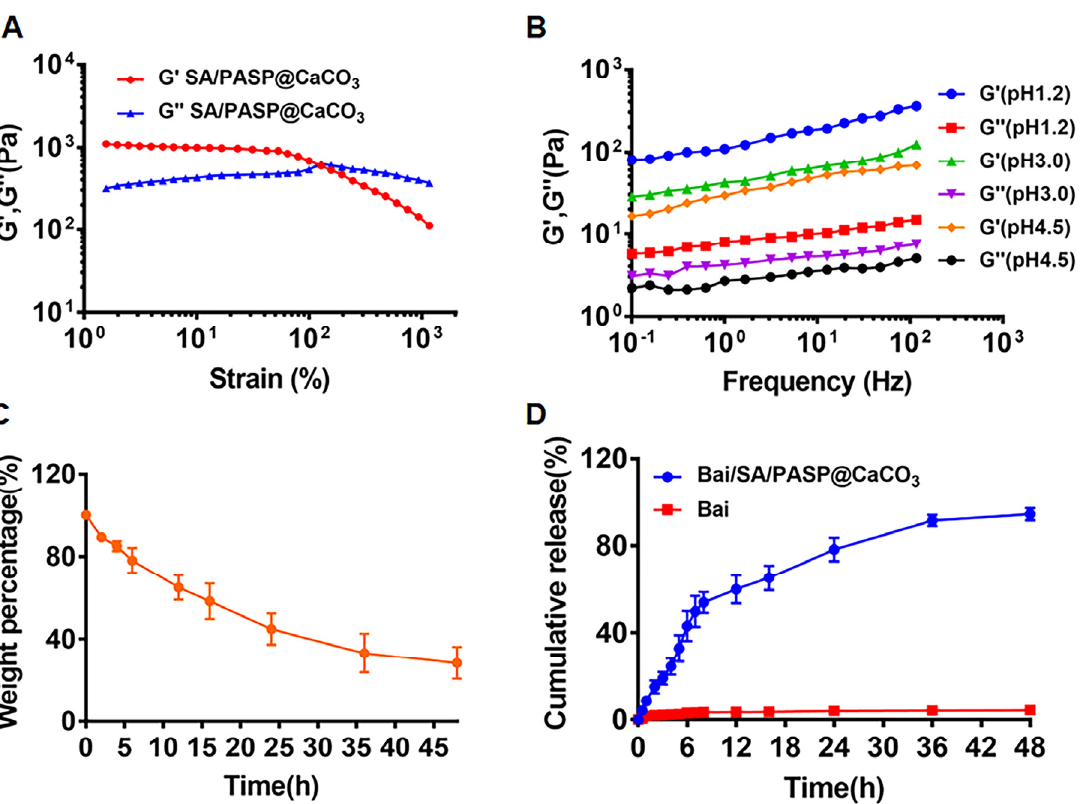
Figure 2. ( A ) The gelation comparison of the SA/PASP@CaCO 3 hydrogels. ( B ) Images show the moduli of the SA/PASP@CaCO 3 in different pH solutions. ( C ) The weight percentage variation of SA/PASP@CaCO 3 in pH 1.2 HCl solution. ( D ) In vitro release profile. The data are expressed as mean ± SD ( n = 3).